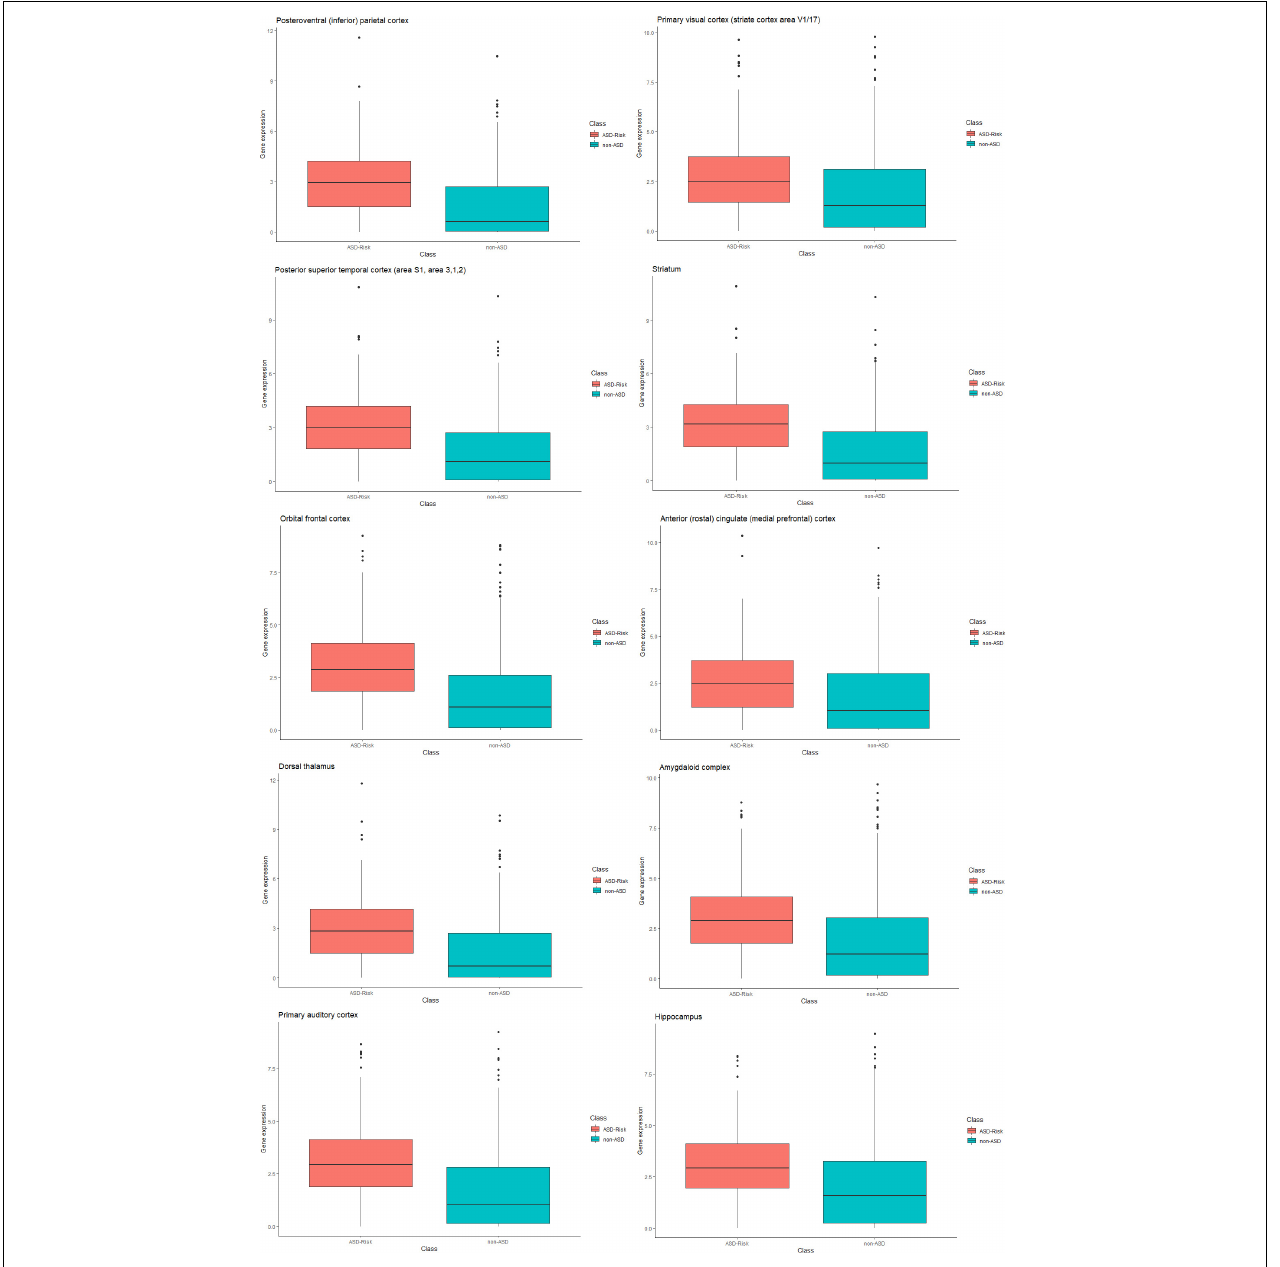
FIGURE 3 | Box plot representation of gene expression in ASD and non-ASD. Each box plot represents gene expression differences in temporospatial time points. The X-axis represents ASD and non-ASD expression levels across all samples, and the Y-axis represents gene expression values (RPKM).